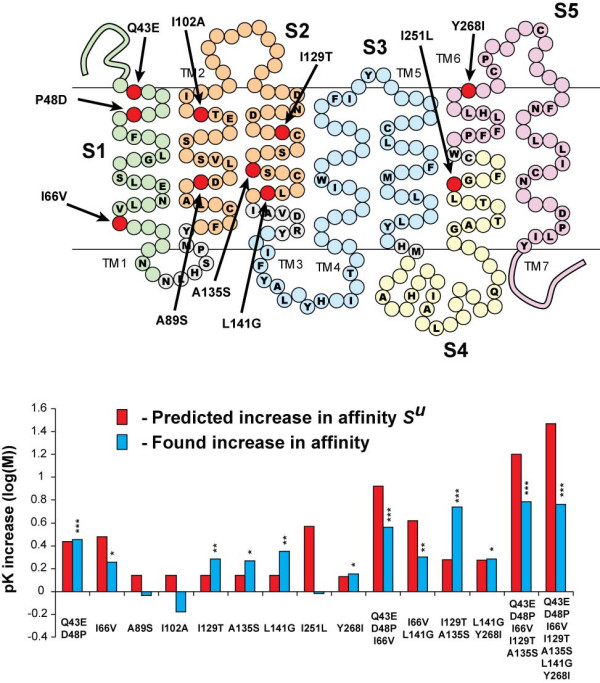
Predicted and experimentally determined increase in α-MSH affinity for site-directed mutants. Predicted and experimentally determined increase in affinity (i.e., computed SU and measured pK increase, log(M), respectively) for α-MSH afforded by point mutations in the MC4 receptor. Shown by red bars is the change in affinity predicted by the model utilizing physicochemical descriptions of amino acids of the receptors' transmembrane regions and facing potential ligand binding clefts to be afforded by the indicated point mutations (i.e., the predicted increase in affinity that should be gained by exchanging the indicated amino acids in the MC4 receptor with the corresponding ones in the MC1 receptor). Shown in blue bars is the experimentally determined change in affinity for these mutations vs. the wild-type MC4 receptor. Significance (nonparametric Wilcoxon Rank Sum statistical test [29]) denoted as follows: * p <0.05; ** p < 0.005; *** p < 0.0005.